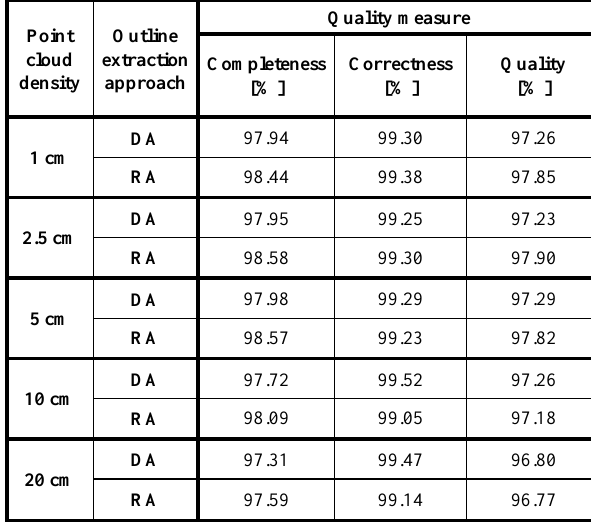
Table 2. The results of quality analysis of building outline